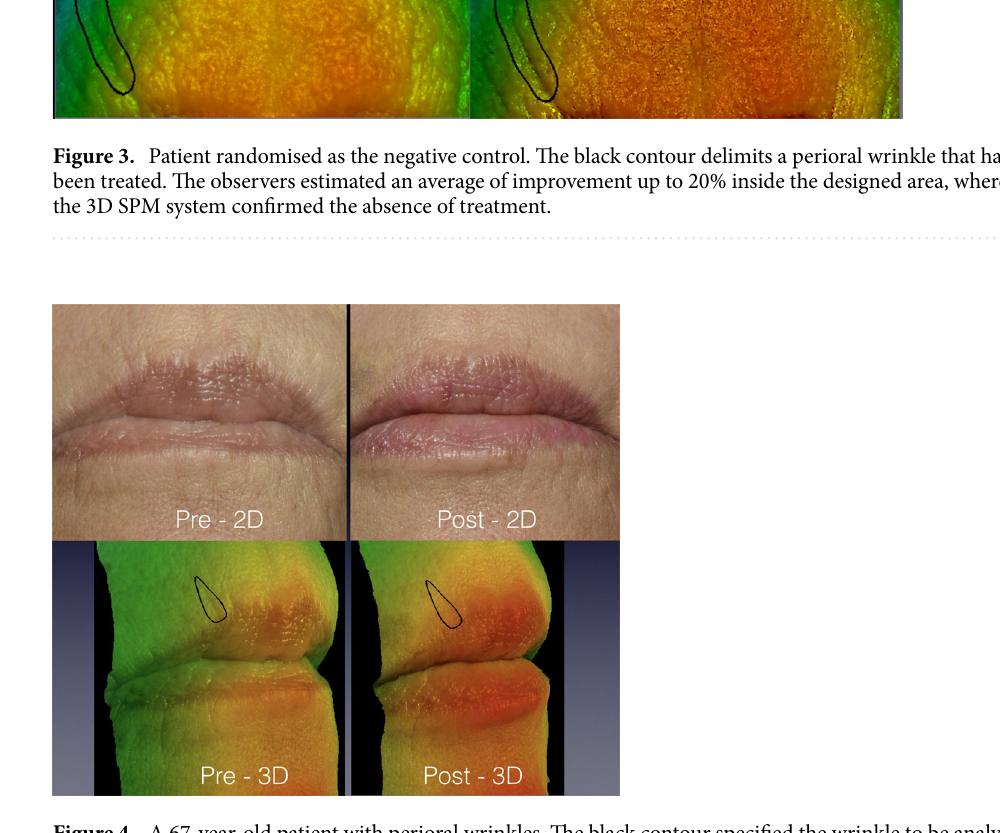
Figure 4. A 67-year-old patient with perioral wrinkles. The black contour specified the wrinkle to be analysed by the observers and by 3D SPM. Both methods agreed that the wrinkle demonstrated a mild improvement (<